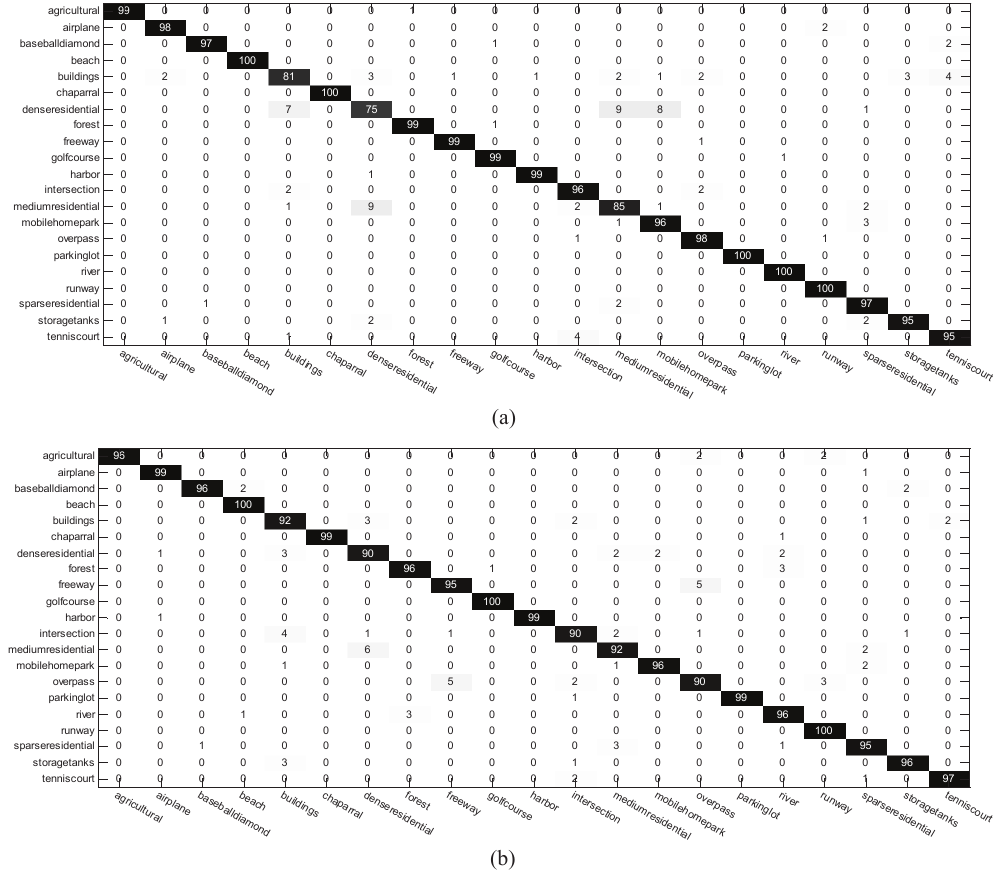
Figure 5. The confusion matrix of the classification results based on ( a ) CNN-W and ( b ) CNN-R on the UC-Merced dataset.